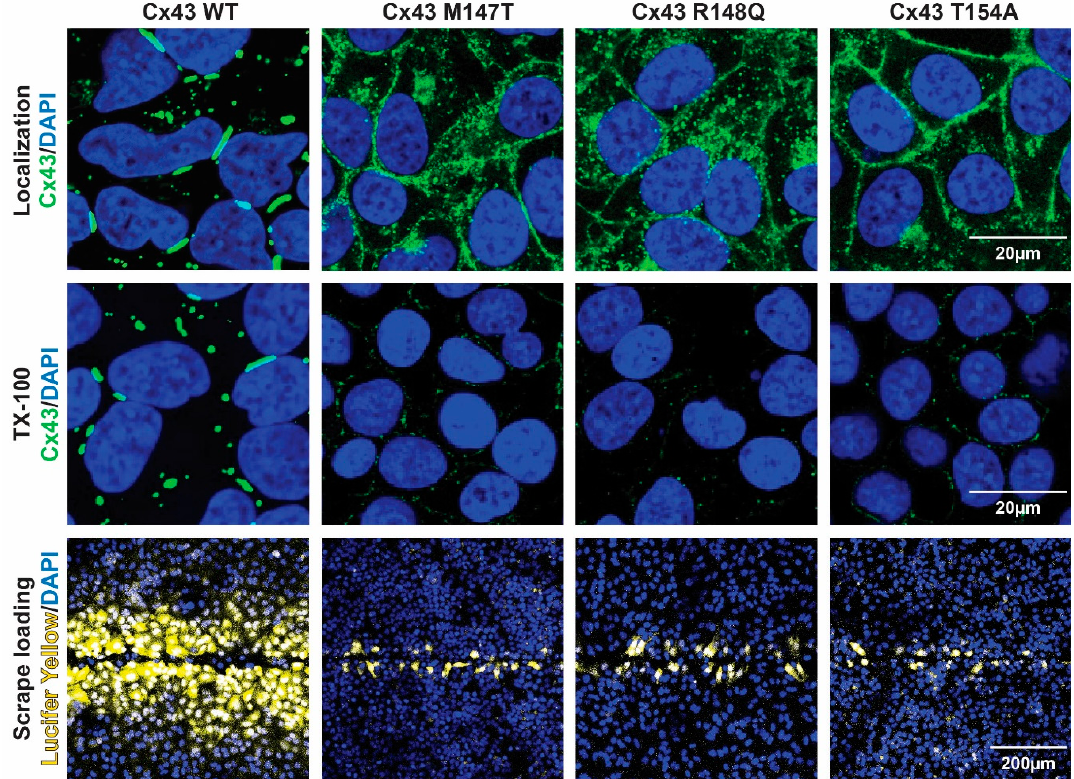
Figure 6. Effect of the Cx43CL ODDD mutations M147T, R148Q, and T154A on cellular localization and intercellular communication. Top panel: Immunofluorescence of HeLa cells stably transfected with Cx43 WT or ODDD mutants M147T, R148Q, and T154A (green, Cx43; blue, DAPI). Middle panel: Immunofluorescence of the same HeLa cells after in situ Triton X-100 extraction (green, Cx43; blue, DAPI). Bottom panel: Level of gap junction communication for each cell line was estimated using the scrape loading dye transfer assay (yellow, Lucifer yellow; blue, DAPI).